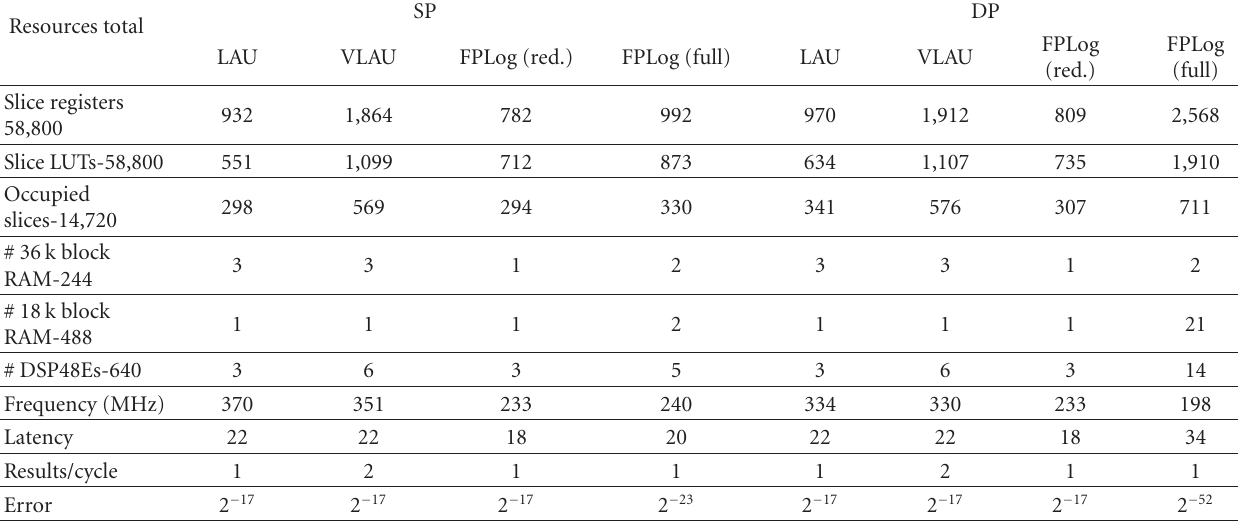
Table 5: Resources, performance, and accuracy of LAUs, VLAUs, and FPLogs.